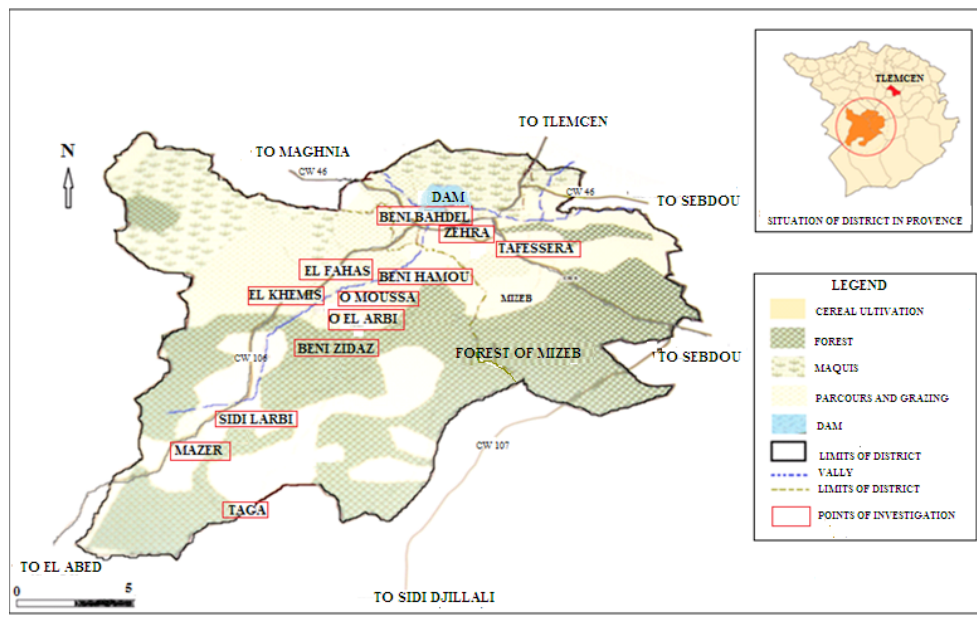
Figure 1. Localities investigations in the zone of study